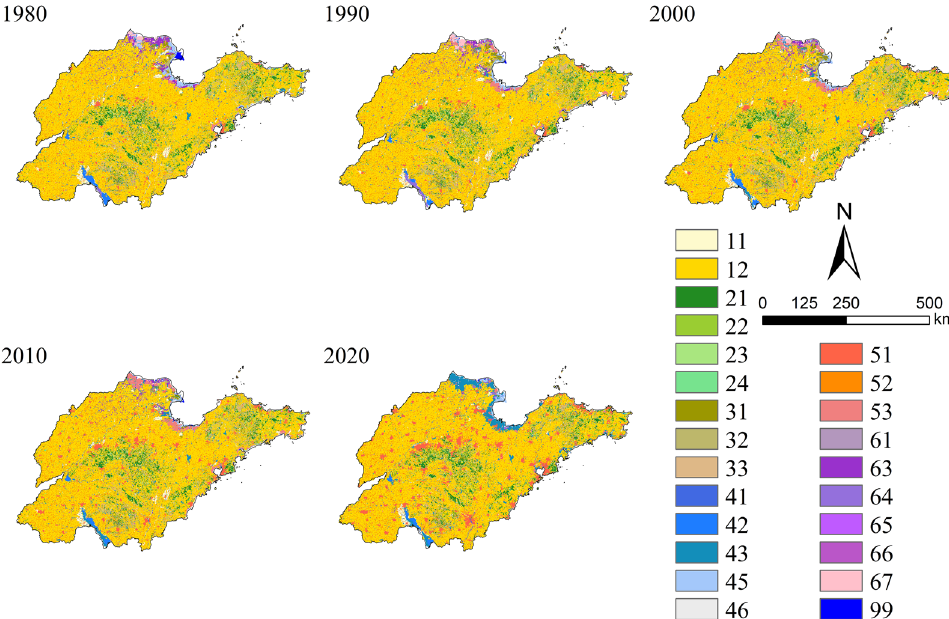
Figure 2. Land use type map of Shandong Province from 1980 to